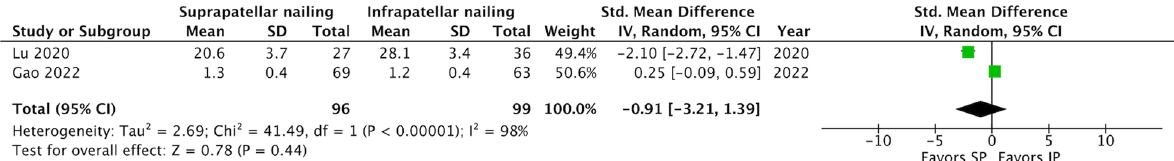
Fig. 2 Forest plot of pain at 1 year after surgery. There was no significant difference between the two groups concerning the level of pain reduction (SMD: 0.92, 95% CI 3.19 to 1.35; P 0.43; I 2 98%). MD median difference, CI confidence interval − − = =